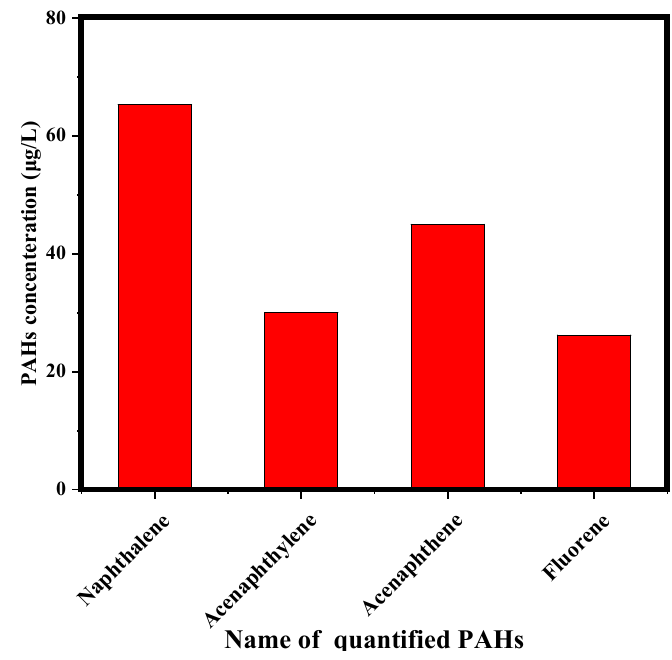
Figure 8. Concentration of PAHs in produced water after optimization of heterogeneous Fenton like oxidation system.